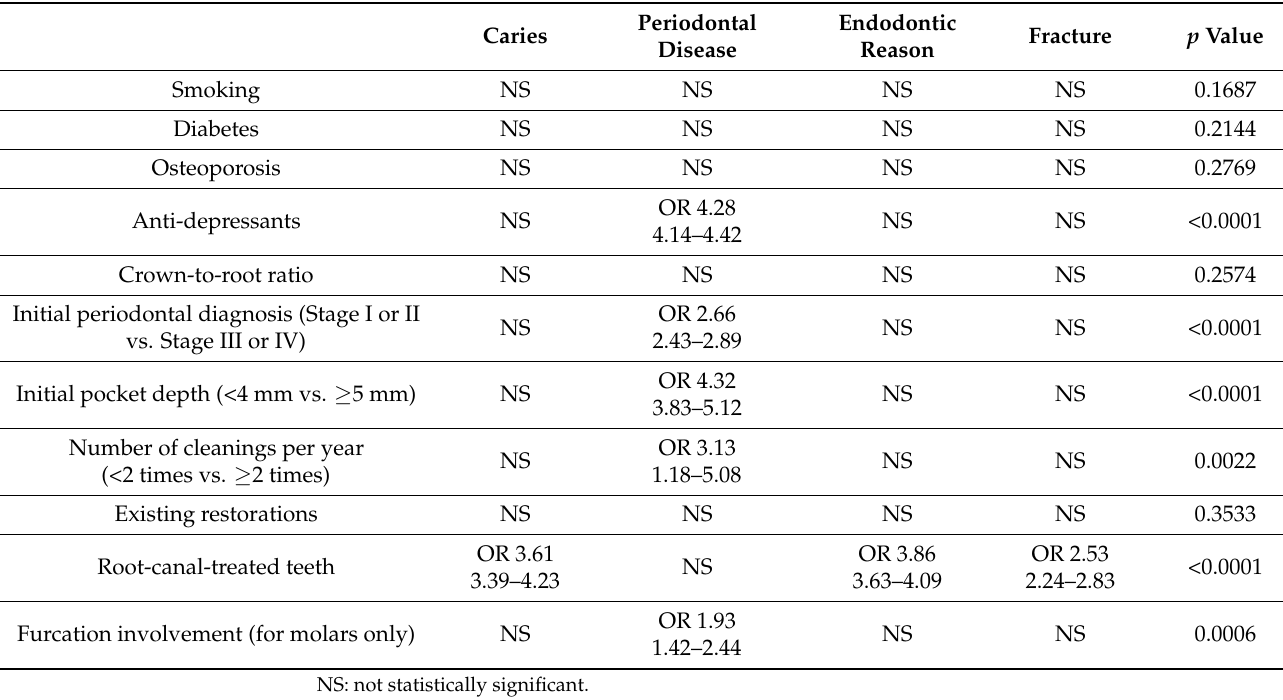
Table 3. Risk indicators of tooth loss for each category using a linear mixed model.